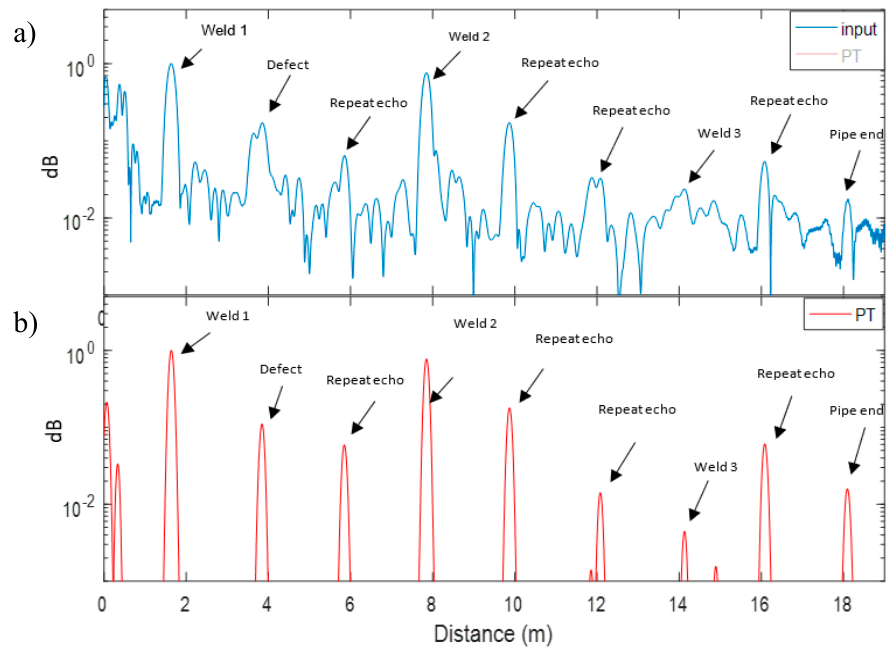
Figure 12. Pipe B log results: ( a ) unprocessed Teletest data, ( b ) SSP result for the whole length of the trace.